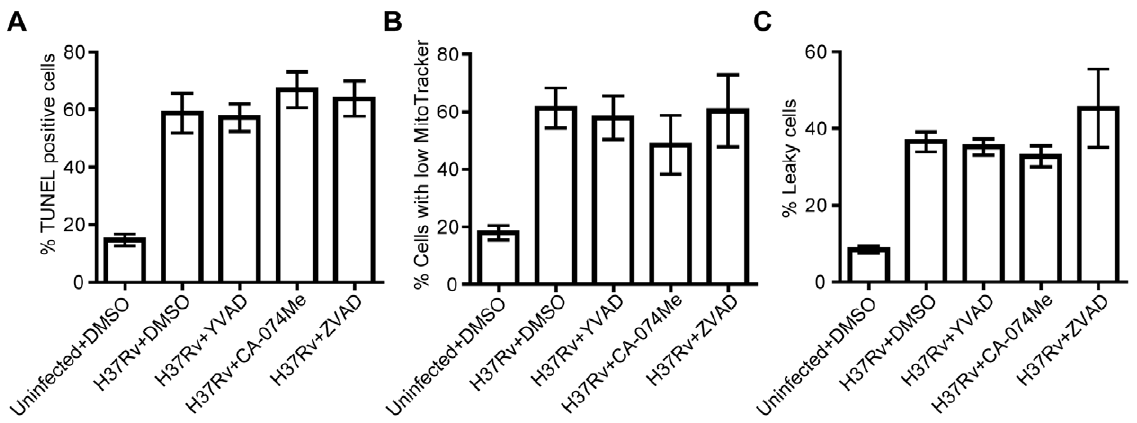
Figure 4. Effect of inhibitors on cell death. hMDMs were treated with DMSO (1:1000) or inhibitors (50 m M) dissolved in DMSO, and infected with H37Rv at MOI 10 or left uninfected. After two days, the features of cell death were analyzed using three different staining procedures and flow cytometry. A ) TUNEL analysis of DNA fragmentation (n $ 4). B ) MitoTracker analysis of mitochondrial membrane potential loss (n $ 4). C ) Plasma membrane integrity analysis (n $ 4). Bar graphs show the mean and SEM. The means were compared to that of H37Rv-infected and DMSO-treated hMDMs using ANOVA with Dunnett’s post-hoc test.